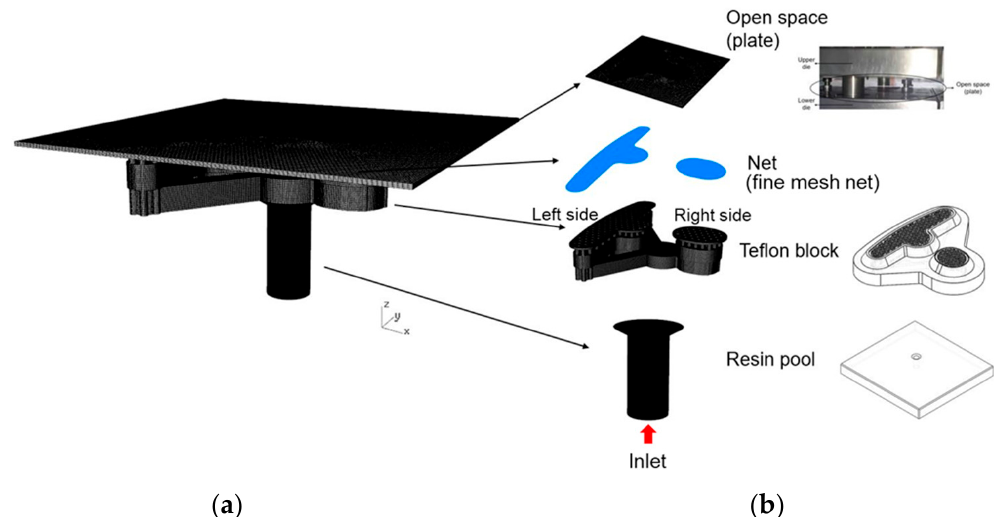
Figure 8. The design of Case 1. ( a ) The overall design of Case 1 and ( b ) the individual design of the plate, the fine mesh nets, the Teflon block, and the resin pool of Case 1.